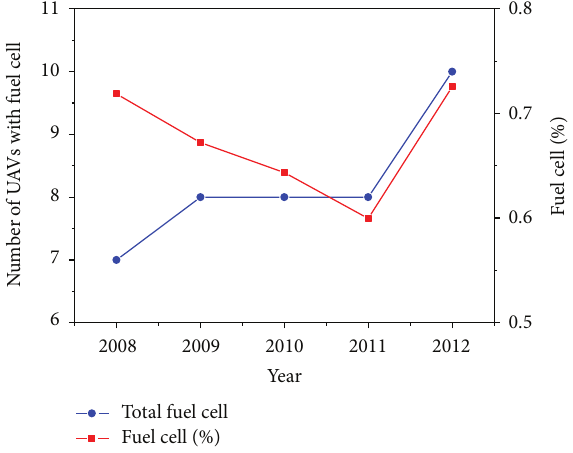
Figure 5: 2008–2012 evolution with % fuel cell UAVs trend.